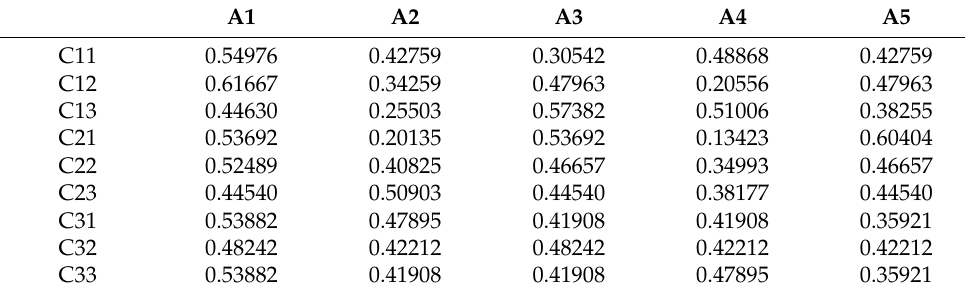
Table 5. Normalized matrix.